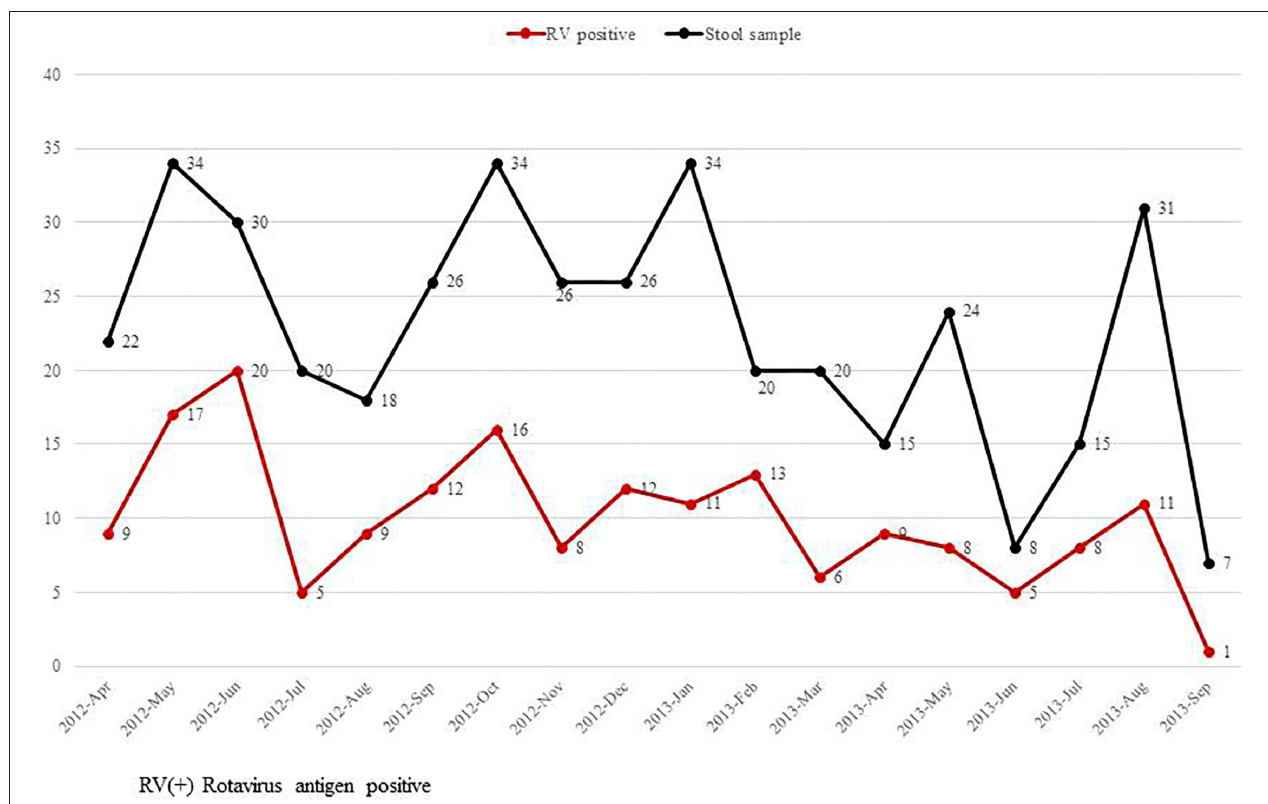
FIGURE 3 | Monthly incidence of rotavirus infection in the neonatal intensive care unit from April 20, 2012 to September 10,